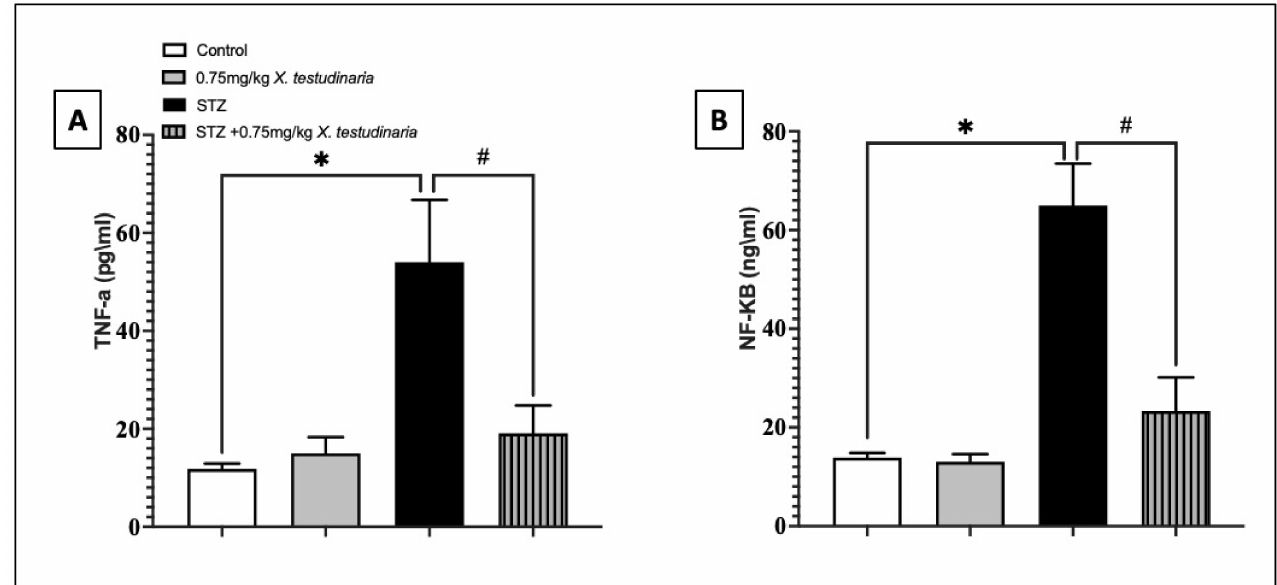
Figure 8. Effect of X. testudinaria extract on tumor necrosis factor (TNF)- α ( A ) and nuclear factor kappa B (NF- κ B) ( B ) content in DRG of streptozotocin (STZ)-induced diabetic neuropathic